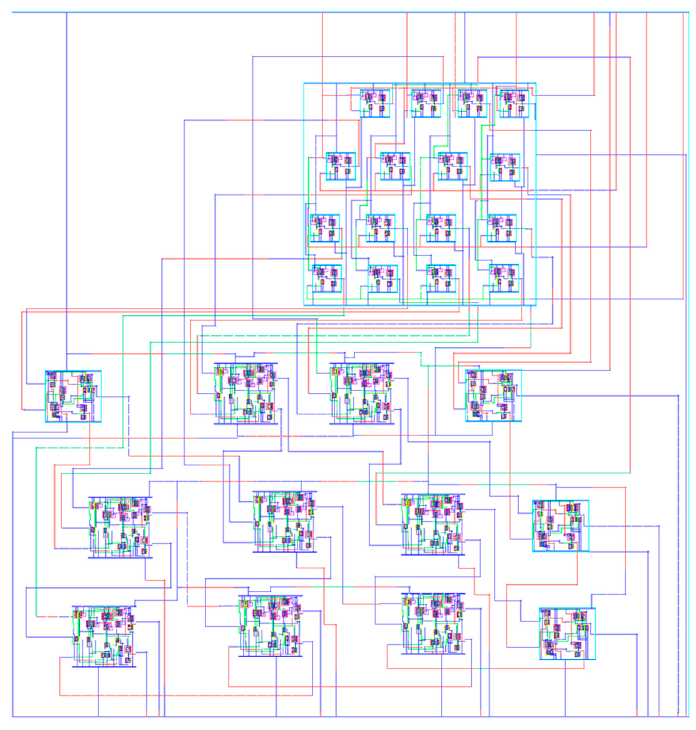
Figure 10. DRC, LVS cleaned, physical design implementation of 4 × 4 Wallace multiplier.